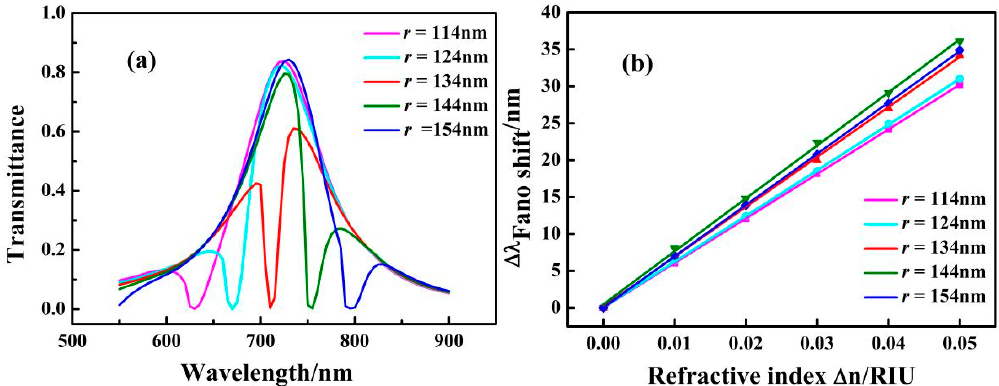
Figure 6. ( a ) Transmission spectrum for different versus of the coupling distance g ; ( b ) Fitting curve of Fano resonance peak shift caused by the refractive index change of Δ n with different values of g .